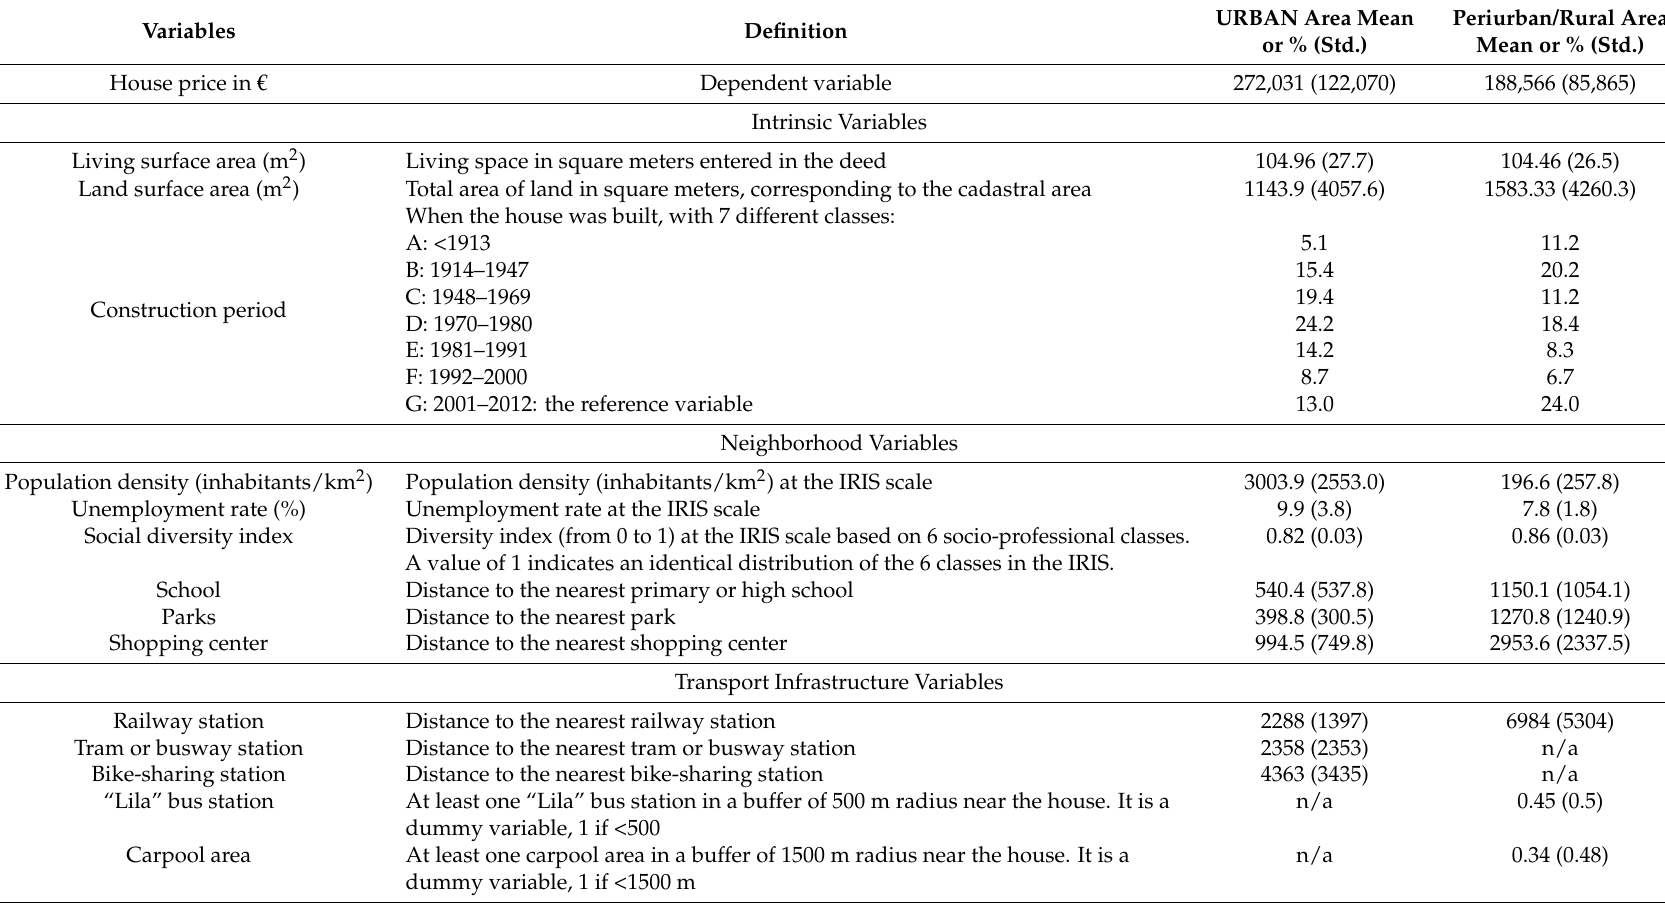
Table 1. List and descriptive statistics of the variables used in this